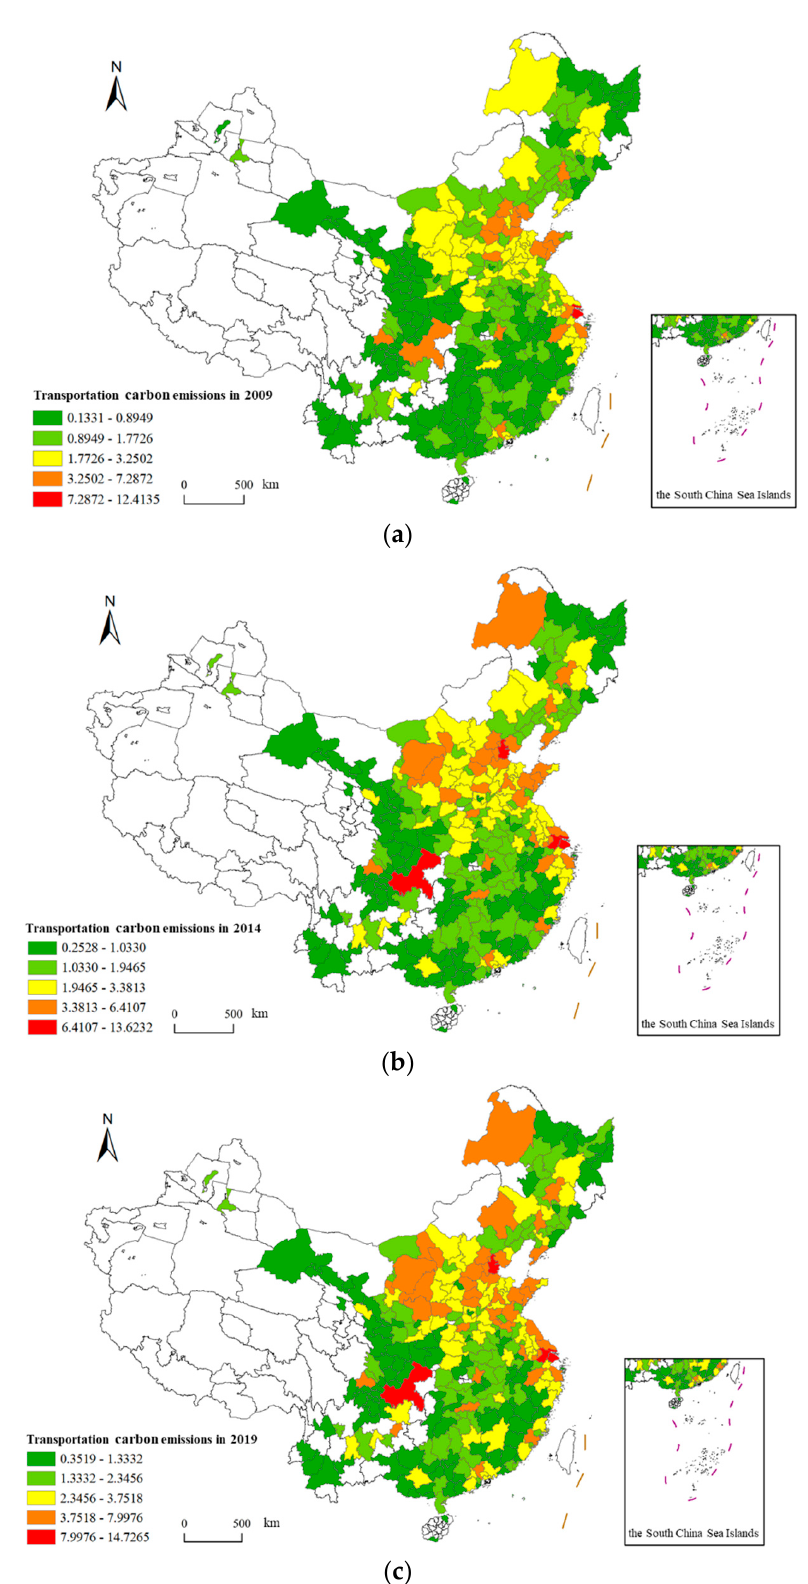
Figure 1. Spatial distribution of transportation carbon emissions in characteristic years. ( a ) Spatial Distribution of Transportation Carbon Emissions in 2009; ( b ) Spatial Distribution of Transportation Carbon Emissions in 2014; ( c ) Spatial Distribution of Transportation Carbon Emissions in